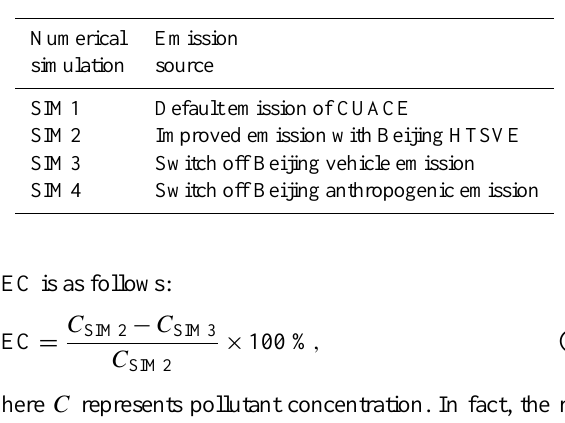
Table 1. Numerical simulation schemes. Table 2. Emission of major anthropogenic species in Beijing (unit: